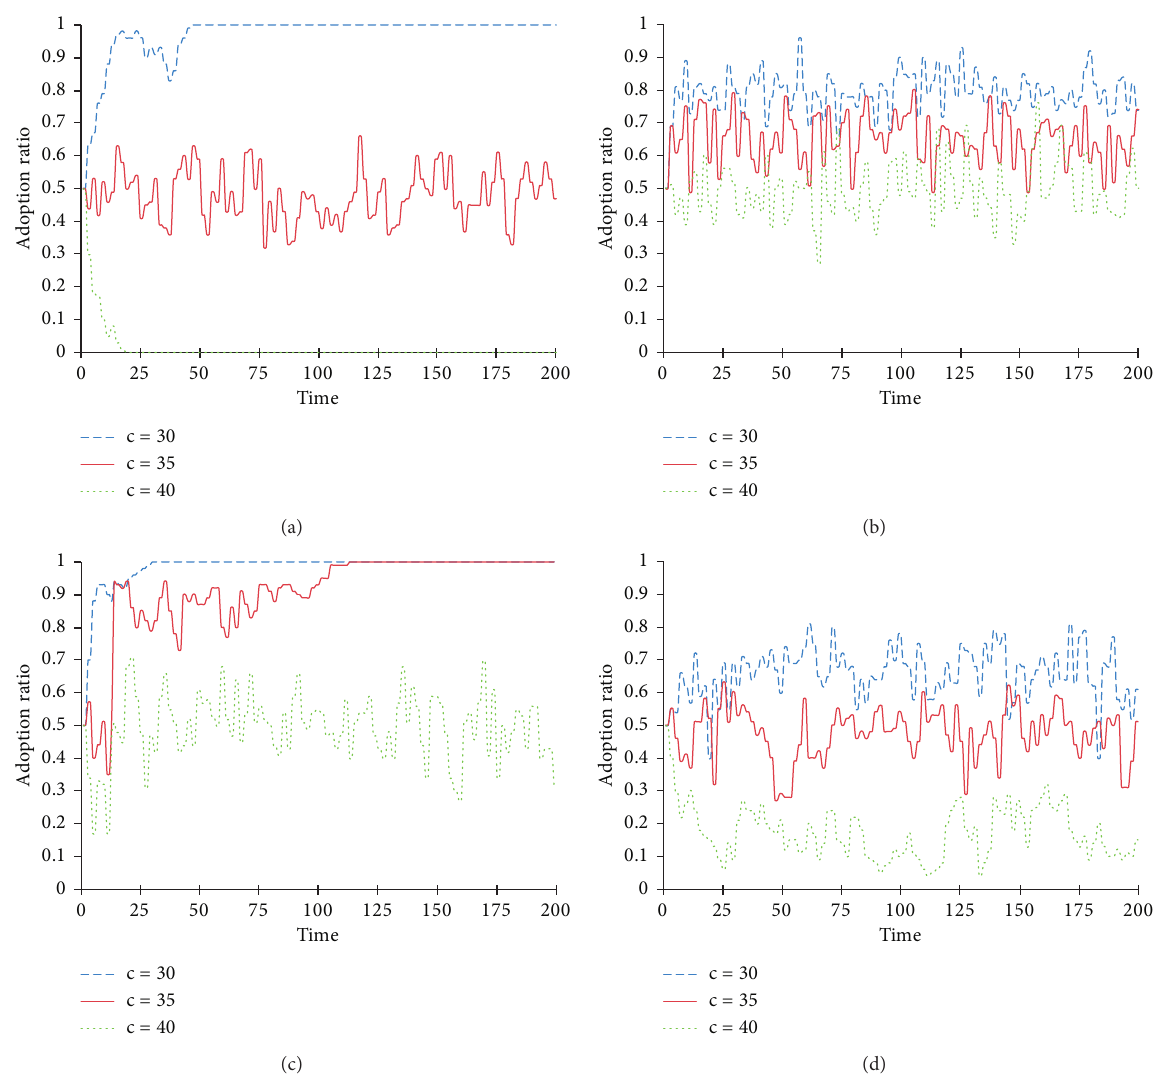
Figure 9: Impact of adoption cost on product diffusion. (a) No overconfidence model. (b) Benefit and cost overconfidence model. (c) Benefit overconfidence model. (d) Cost overconfidence